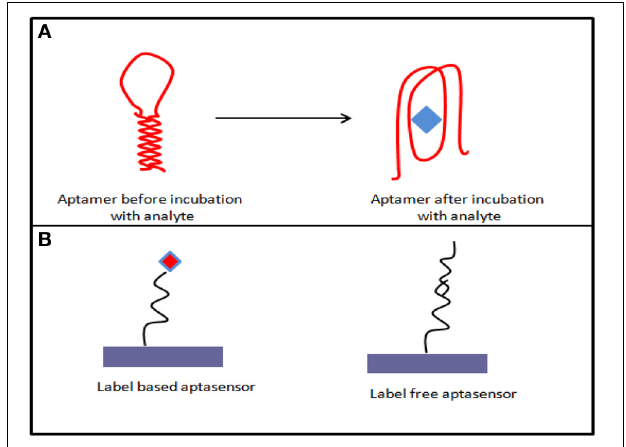
FIGURE 1 | (A) Aptamer conformational changes after target analyte incubation; (B) various possible formats of